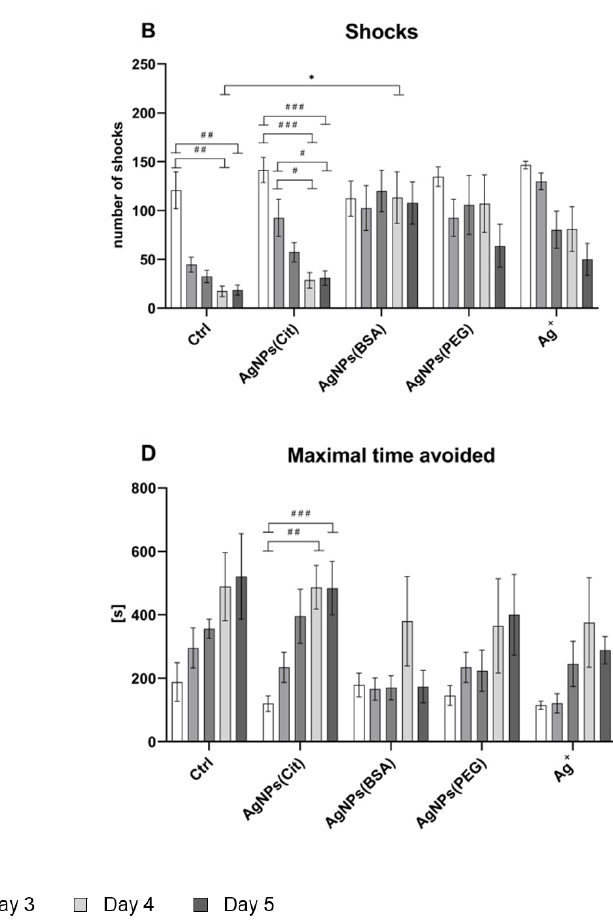
Figure 2. Behavioral measures of spatial memory assessed on 5 days of the active allothetic place avoidance training in rats exposed to AgNPs with different types of coating (citrate, BSA, and PEG) or Ag + ; Ctrl rats received water. Memory acquisition: ( A )—number of entrances (two-way repeated measures ANOVA: effect of group, F 4,22 =4.18, p = 0.006; effect of day, F 4,88 = 15.97, p = 0.000; effect of group-by-day interaction, F 4,88 = 2.11, p = 0.01); ( B )—number of shocks (the same ANOVA: effect of group, F 4,25 = 3.61, p = 0.019; effect of day, F 4,100 = 20.17, p = 0.001; effect of group-by-day interaction, F 4,100 = 2.08, p = 0.015); skill learning: ( C )—SHs/ENTR ratio (the same ANOVA: effect of group, F 4,29 = 10.21, p = 0.001; effect of day, F 4,116 = 9.83, p = 0.001); short-term memory: ( D )—Tmax [s] (the same ANOVA: effect of group, F 4,29 = 3.27, p = 0.025; effect of day, F 4,116 = 12.40, p = 0.001) (mean ± SEM). *, **, and ***: Significantly different from the Ctrl group at the same time point (* p < 0.05, ** p <0.001, and *** p < 0.001) (Tukey post hoc test). # , ## , and ### : Significantly different within the same experimental group at different time points ( # p < 0.05, ## p < 0.001, and ### p < 0.001) (Tukey post hoc test). • Significantly different between AgNPs(Cit) group and AgNPs(BSA) group on 5 days of memory acquisition ( • p < 0.05) (Tukey post hoc test).